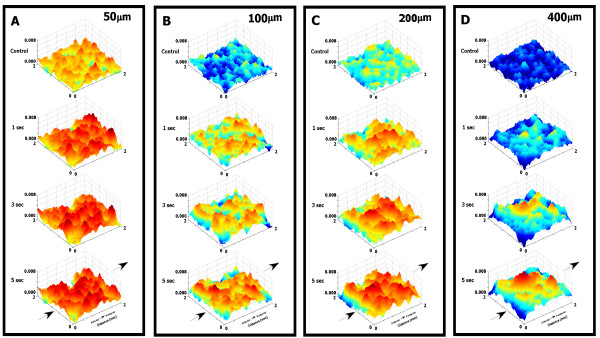
Comparison of temporal development of cortical patterns of absorbance evoked by different amplitudes of flutter vibration. 3-D activity maps of the same cortical region (of the same subject) are plotted at -1 (control), 1, 3 and 5 secs after the stimulus onset for amplitudes of 50, 100, 200 and 400 μm (Panels A, B, C, & D respectively; in all panels, color-scales are normalized by their maxima). Note the difference in the progression of the pattern development evoked by the different stimulus amplitudes.